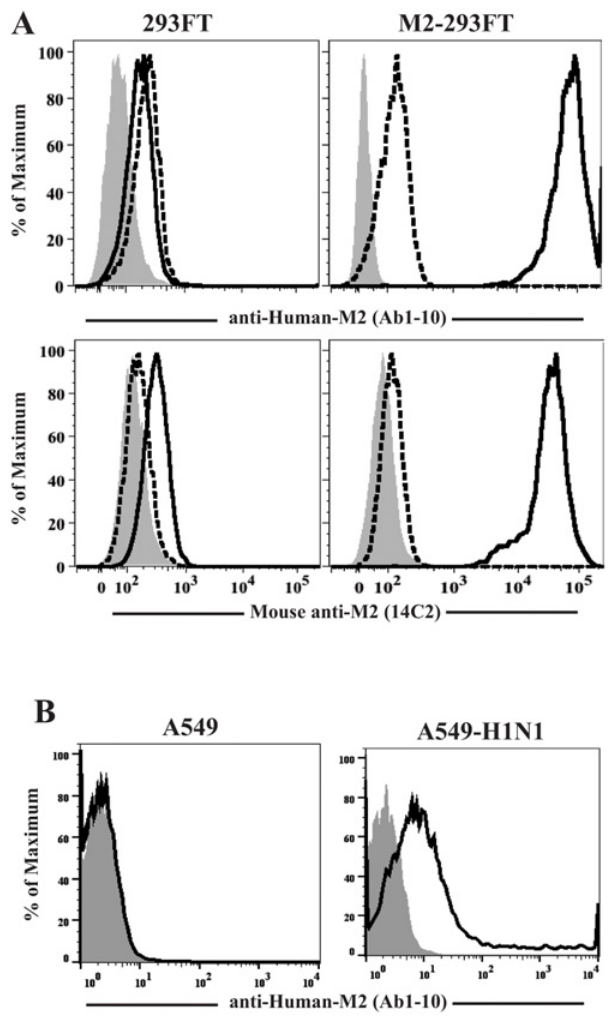
Fig 1. Human Ab1-10 mAb recognizes M2e on animal cells. (A) 293FT cells (left) and M2-293FT cells (right) were cell surface stained with the human anti-M2 Ab1-10 mAb (upper panel) and the mouse anti-M2 14C2 mAb (lower panel) and analyzed by flow cytometry. Shaded histograms represent unstained cells. The binding of the isotype controls (dotted line) and anti-M2e specific mAbs (black line) is shown. (B) Uninfected A549 (left) and influenza infected (right) A549-H1N1 cells were cell surface stained with the human anti-M2 Ab1-10 mAb. The binding of secondary Ab alone (grey histogram) and the binding of Ab1-10 mAb (black line histogram) is